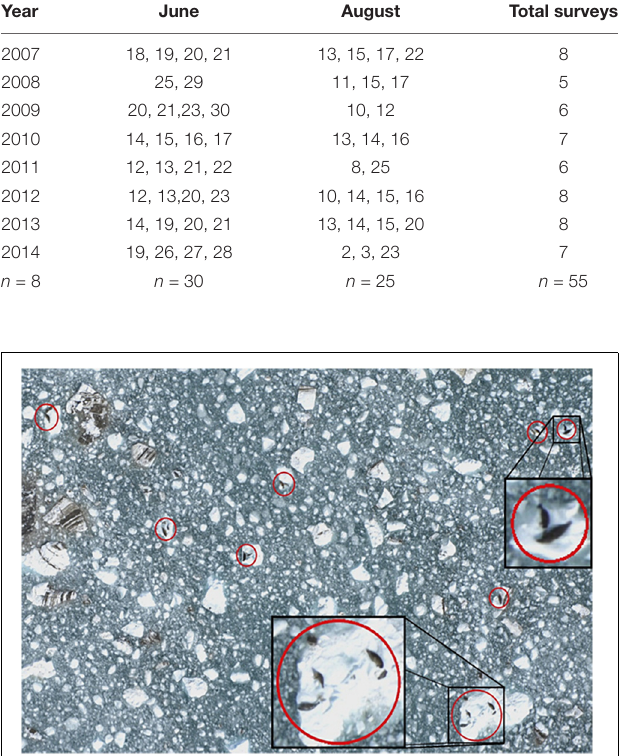
FIGURE 3 | Example digital image of harbor seals and ice collected during aerial photographic surveys in Johns Hopkins Inlet in Glacier Bay National Park, southeastern Alaska. Harbor seals, including non-pups and pups, are identified in red circles. Photo: Jamie N. Womble/NPS.